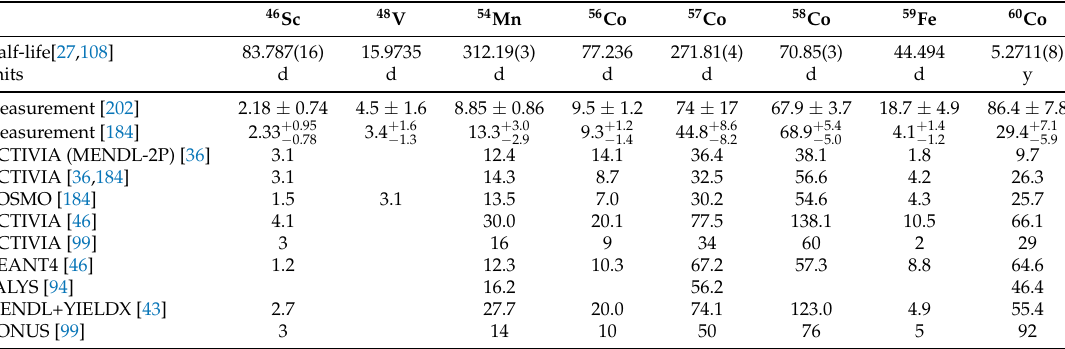
Table 6. Rates of production of long-lived radioisotopes were induced in natural copper at sea level. Measurements from Refs. [184,202] and different calculations are presented (see text). Several cosmic neutron spectra have been assumed in the ACTIVIA calculations from different works. All numbers are expressed in